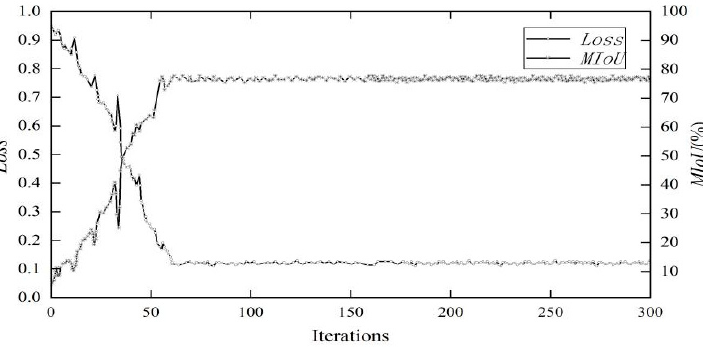
Figure 7. The iteration loss and MIoU of the Front-end+Large network.